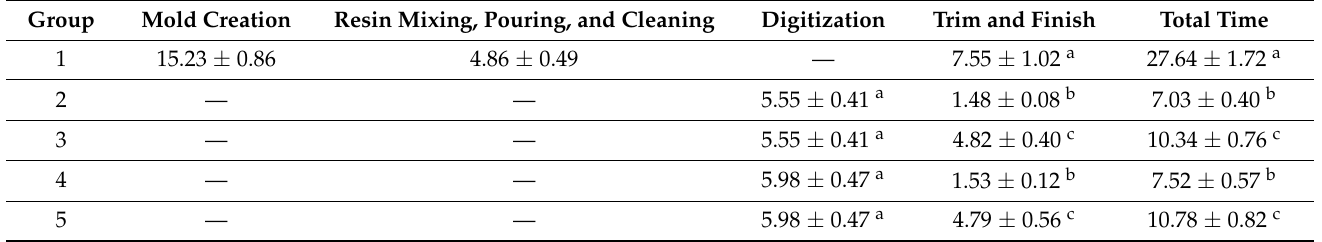
Table 3. Labor time spent (mean ± SD, recorded in